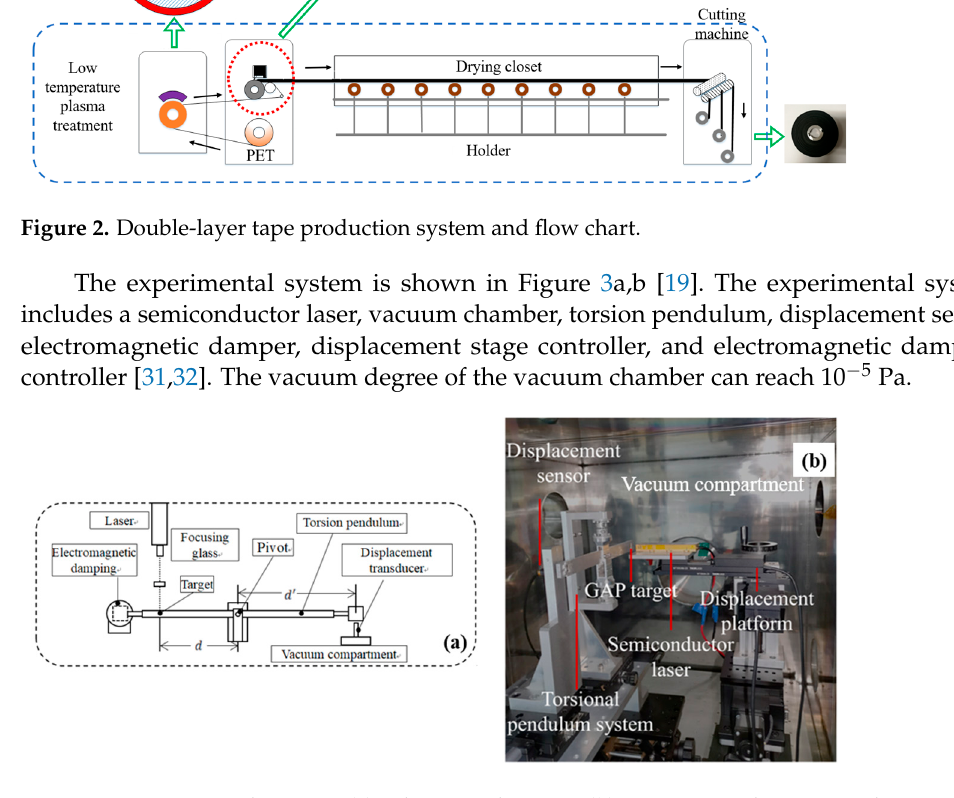
Figure 3. Experimental system. ( a ) Schematic diagram; ( b ) Experimental scene graph. Reprinted with permission from [19]. Copyright 2022, IOP Publishing.